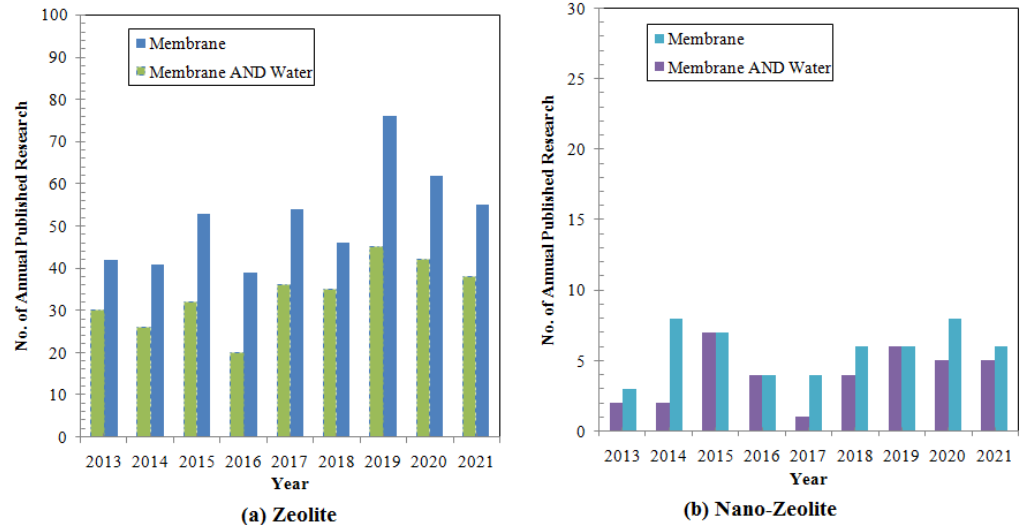
Figure 8. Annual distribution of the research that addressed the application of ( a ) zeolites; ( b ) nano-zeolites in membrane and membrane in water.